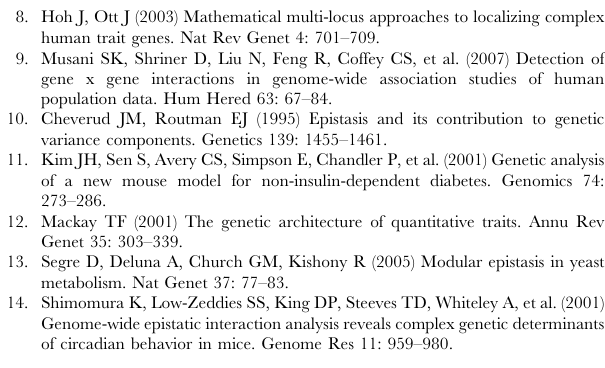
Table S3 Degree distribution of nodes in the genetic-association interaction network (GAIN) in Figure 3 for the smallpox vaccine- associated adverse event phenotype. SNPs are sorted by the degree (number of connections) of each SNP node in the network. SNPs are named according to their SNP500Cancer id (http:// Table